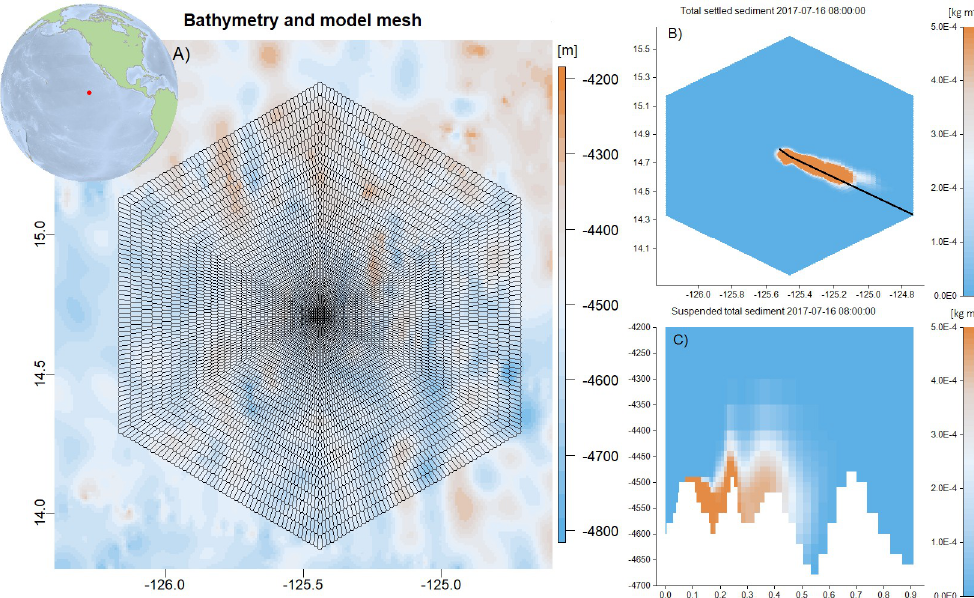
Fig 6. Clarion-Clipperton Zone in the Pacific. A) Location of model domain, computational mesh and bathymetry. B) Total sediment concentration (all fractions, kg m -2 ) that has settled out on the seabed after 16 days of model simulation. C) suspended total sediment in the water column (kg m -3 ) along a transect indicated by the black line B).